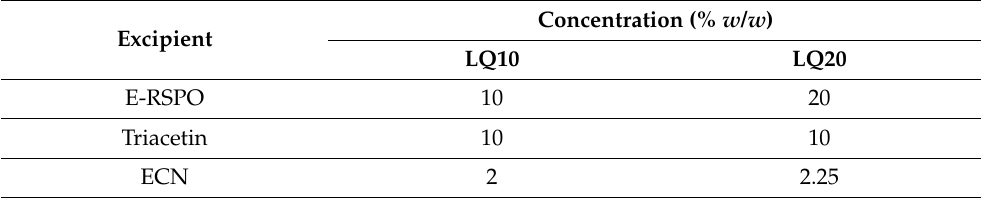
Table 7. Final lacquer comparison to check maximum drug